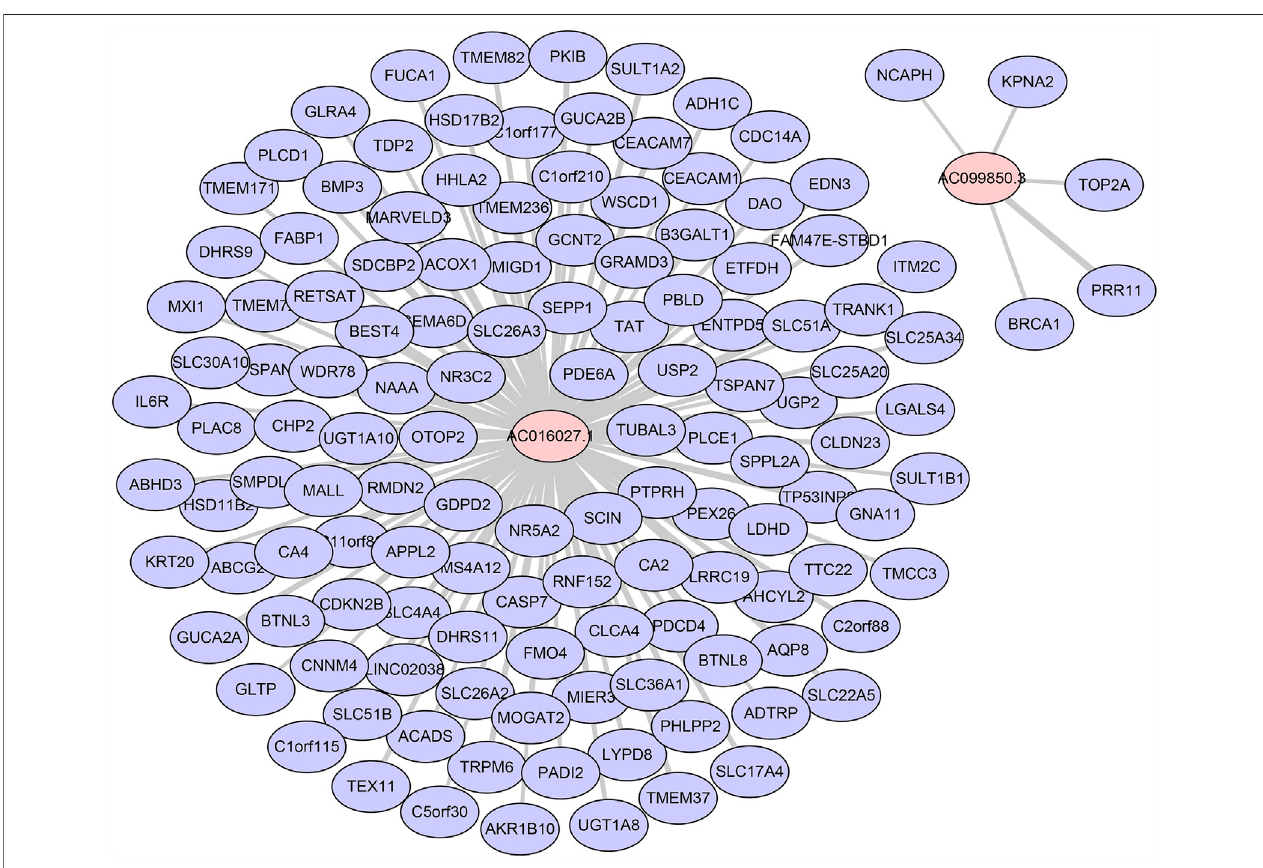
FIGURE 8 | Co-expression network of DE-FLs and